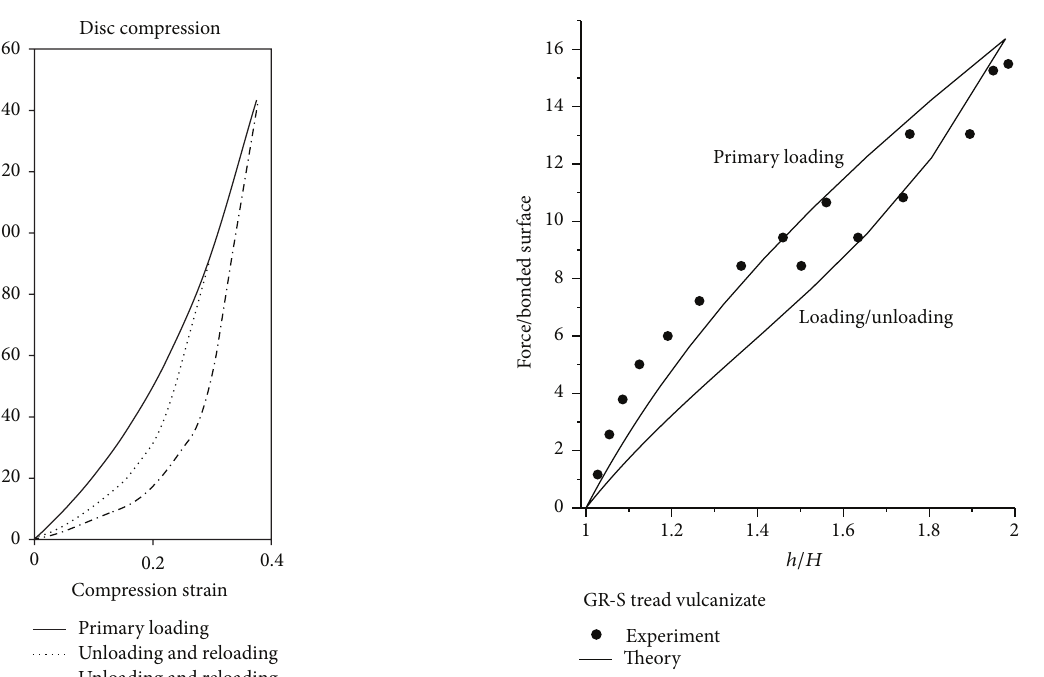
Figure 4: Comparison of theory with Mullins and Tobin [13] uniaxial experiment for 𝑆 = 0 . 𝐸 = 28.5 , 𝛽 = 0.04